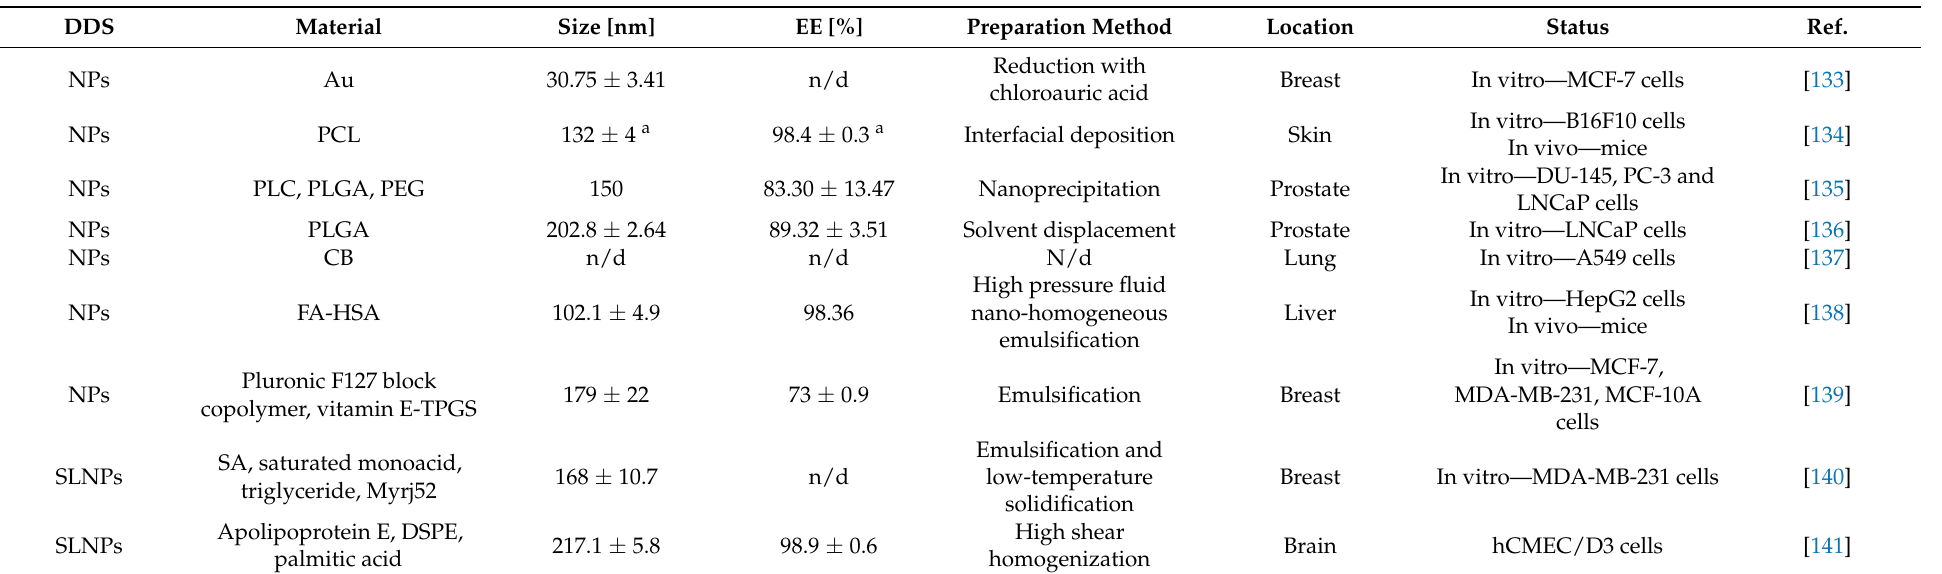
Table 3. The examples of Res–loaded delivery systems for anticancer